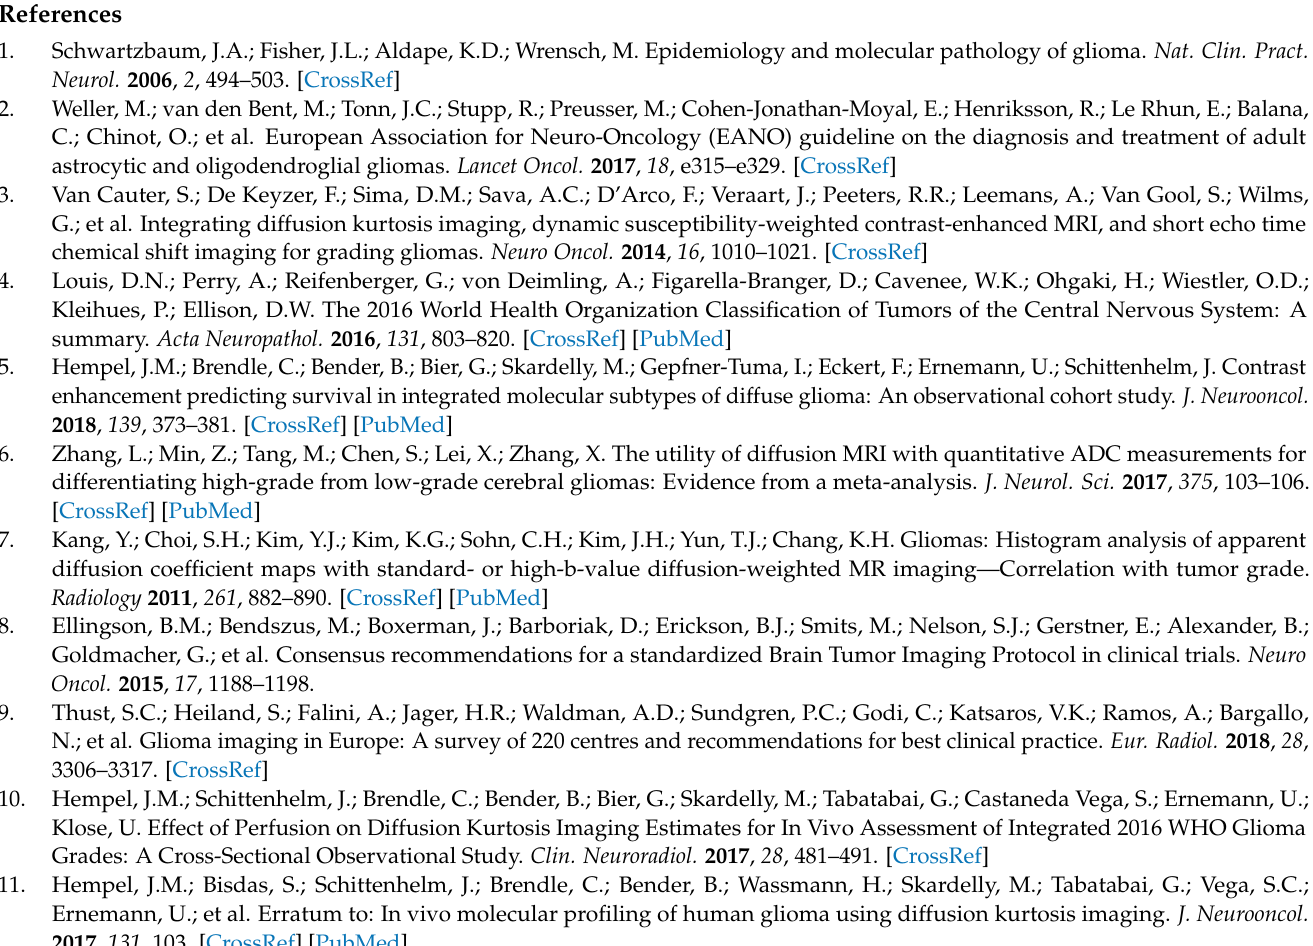
Figure A2. Distribution of the mean kurtosis values using all measured b values from 0 s/mm 2 to 2500 s/mm 2 , classified into the three molecular glioma groups.